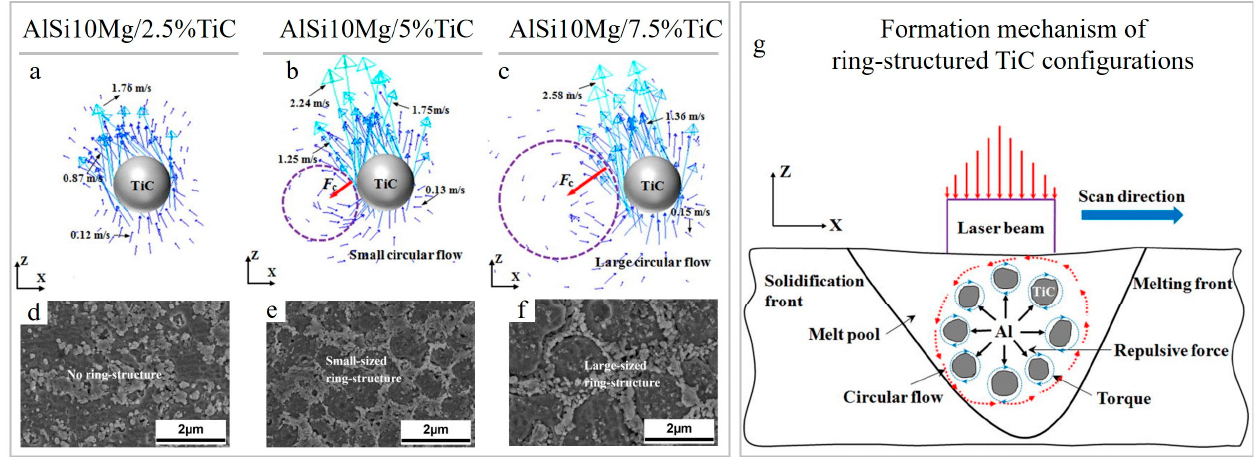
Figure 9. Velocity vector plots around a TiC reinforcing particle in the melt pool (the dashed circles highlight the circular motion) and micrographs demonstrating typical morphology of LPBF-processed AlSi10Mg/TiC nanocomposites with different TiC contents: 2.5 wt.% ( a , d ), 5 wt.% ( b , e ) and 7.5 wt.% ( c , f ). Schematics of the formation mechanism of novel circular TiC configurations during fusion process at fixed E v = 571.43 J/mm 3 ( g ) (reproduced with permission from [22]).